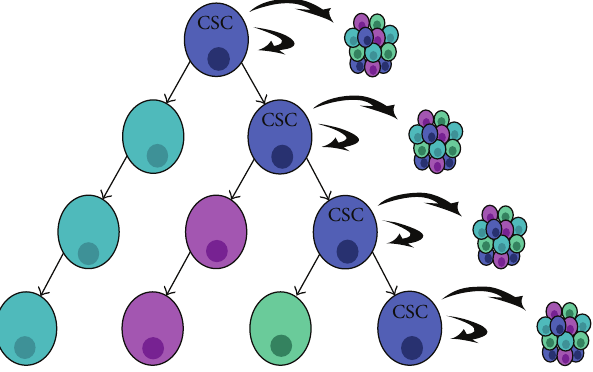
Figure 1: Cancer stem cell model. Tumor cells form a heterogeneous structure and only the cancer stem cells (CSCs) have the ability to self-renew and differentiate into different cell types. CSCs can form new heterogeneous tumors following